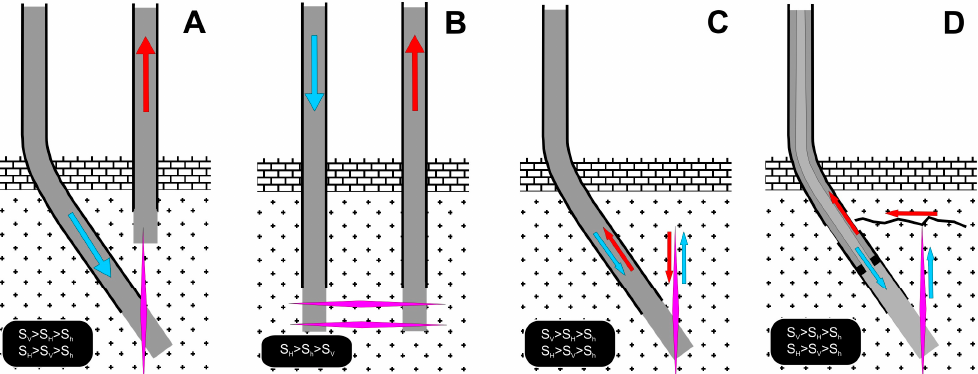
Figure 2. The most common types of underground heat exchanger systems. S V —principal vertical stress; S H , S h —maximum and minimum horizontal stress, respectively. ( A )—doublet in extensional stress regime, ( B )—doublet in lateral compressive regime, ( C )—single directional well for injection and production cycling in extensional stress regime, ( D )—single directional well for continuous injection and production in extensional stress regime.